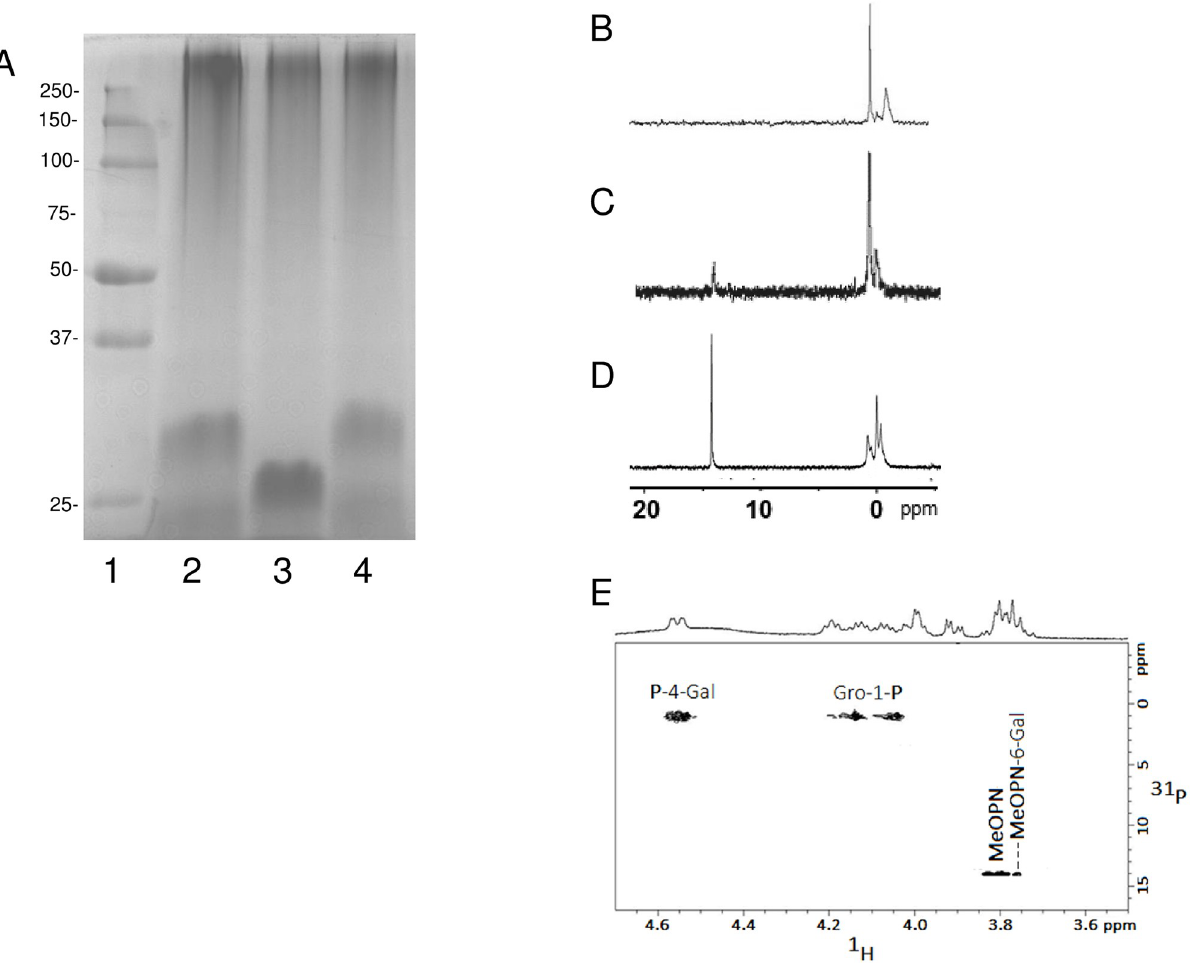
Fig 5. Characterization of mutants in the HS1.08 gene. A. Alcian blue stained 12.5% SDS PAGE of crude CPS preparations. Lane 1, Precision Plus protein standards; lane 2, HS1 wildtype; lane 3, HS1 1.08 mutant; lane 4, HS1 1.08 mutant complemented; B. 31 P NMR of CPS from strain HS1 Δ HS1.08::cat showing the CPS devoid of MeOPN; C. 31 P NMR spectrum of CPS from HS1 1.08 mutant complemented, showing the re-insertion of MeOPN in the CPS.; D. 1D 31 P NMR of C . jejuni HS44 (strain 2871) CPS preparation; E. 1 H- 31 P HMBC NMR of defructosylated C . jejuni HS1 strain